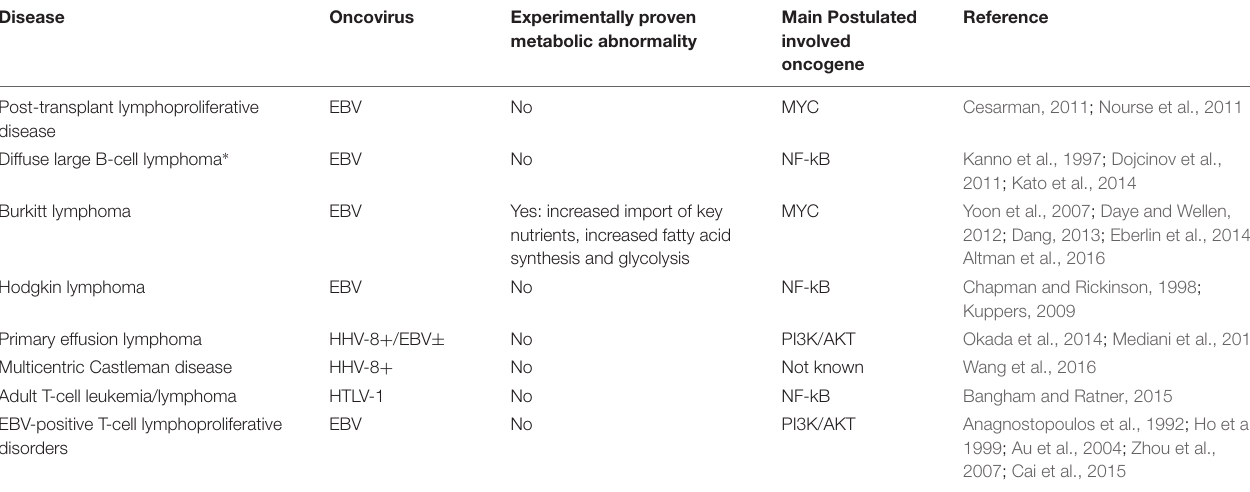
TABLE 1 | Association between oncoviruses and lymphomas.